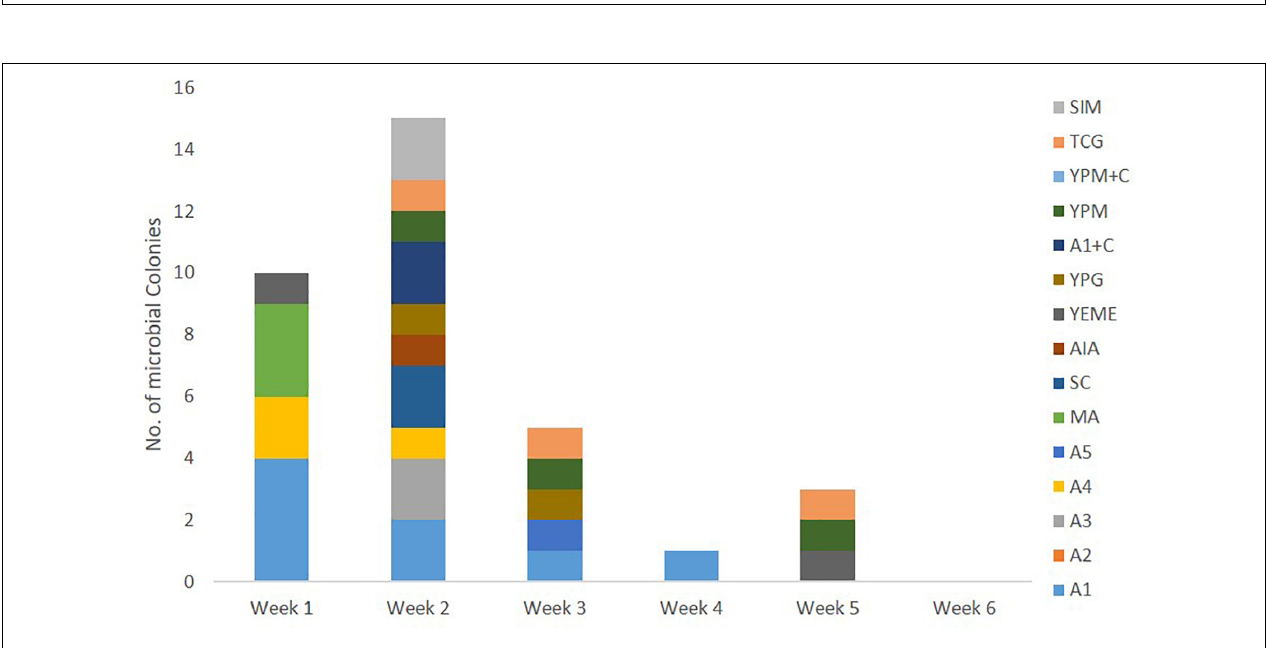
FIGURE 4 | Number of QSI active marine bacterial colonies, with more than 60% florescence inhibition, isolated from samples of Cliona patera , NP1 and NP6, over a 6-week incubation period in various marine media.